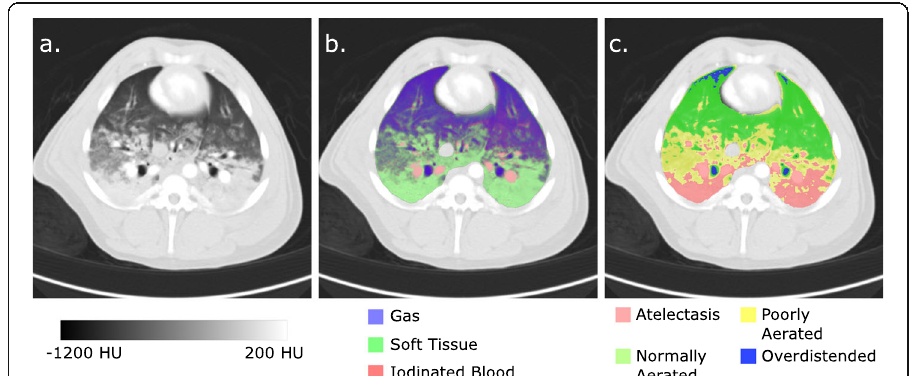
Fig. 1 Example CT images of the juxtadiaphragmatic slice used in this study. a 70%:30% merge of the two dual-energy CT images using standard lung windows. b Results of segmentation to exclude extrapulmonary structures and dual-energy three material differentiation demonstrating gas, soft tissue and iodinated blood volume fractions. c Segmentation to identify regions of overdistension (gas volume fraction > 90%), normal aeration (gas volume fraction 50 – 90%), poor aeration (gas volume fraction 10 – 50%) and atelectasis (gas volume fraction < 10%). HU Hounsfield